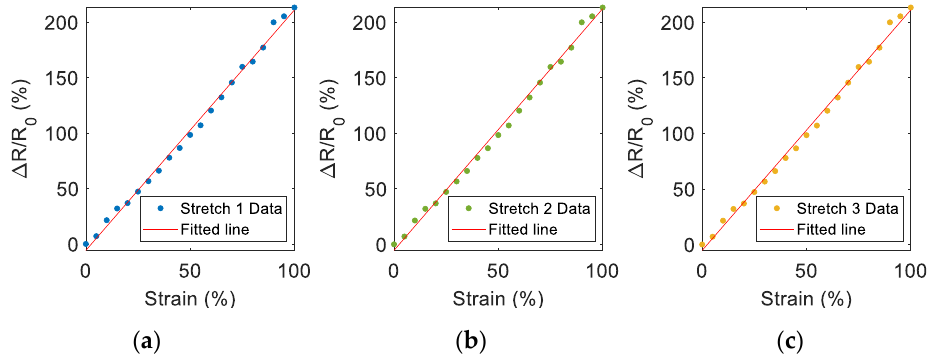
Figure 4. Response of ( a ) Stretch Sensor 1, ( b ) Stretch Sensor 2, and ( c ) Stretch Sensor 3, used for the smart brace according to the elongation expressed as strain. The initial length of the stretch sensors (strain equal to 0%) is 100 mm. The red lines are the lines of best fit for each set of measured data.